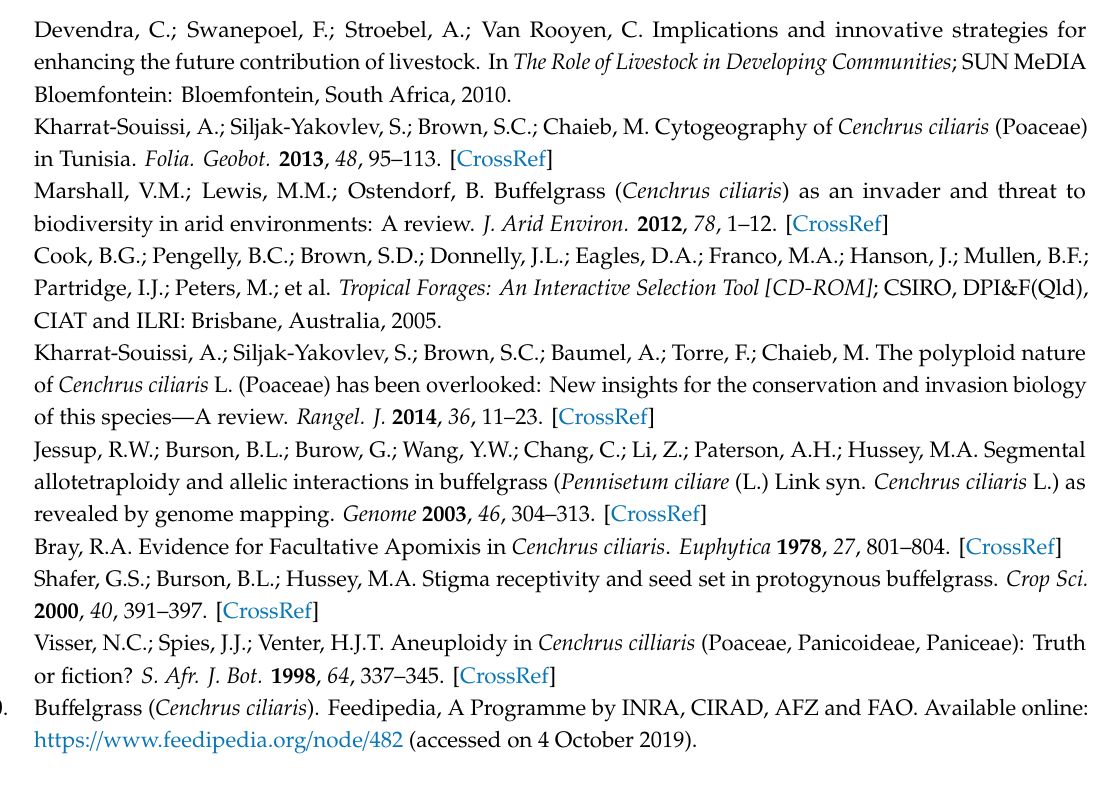
Table S1: Passport data of bu ff elgrass collection, Table S2. Number for accessions in di ff erent clusters according to their country of origin, Table S3: Bu ff elgrass collections and number of accessions held by centres across the world, Figure S1: Mantel correlation analysis of genetic and geographical distance of the bu ff elgrass accessions Author Contributions: Conceptualization, A.T.N., C.S.J. and J.H.; Data curation, A.T.N.; Formal analysis,